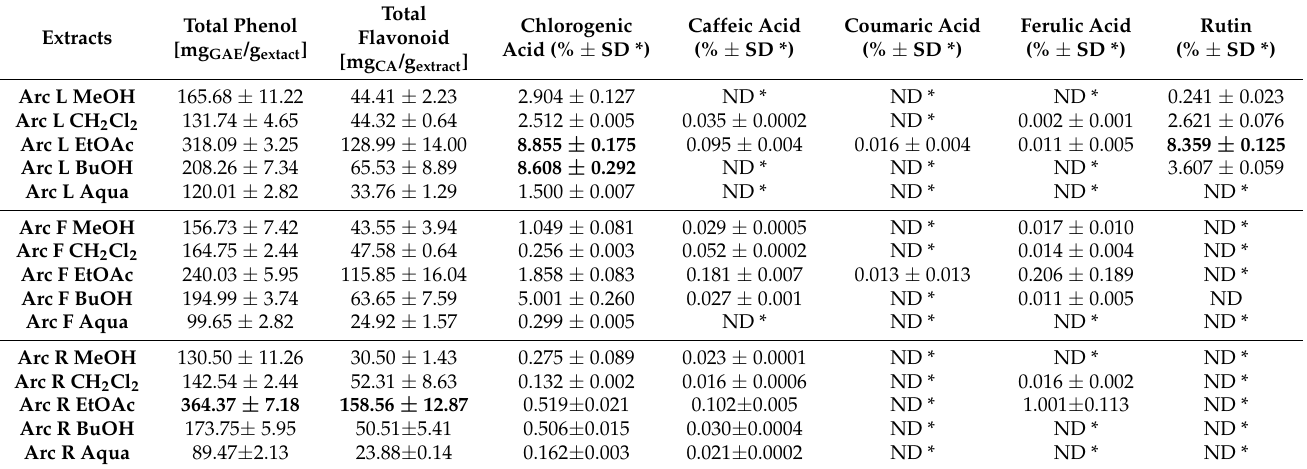
Table 1. Total phenol and flavonoid content and quantitative determination of caffeic acid, chlorogenic acid, coumaric acid, ferulic acid, and rutin in fractions of Arctium minus ( n = 3).